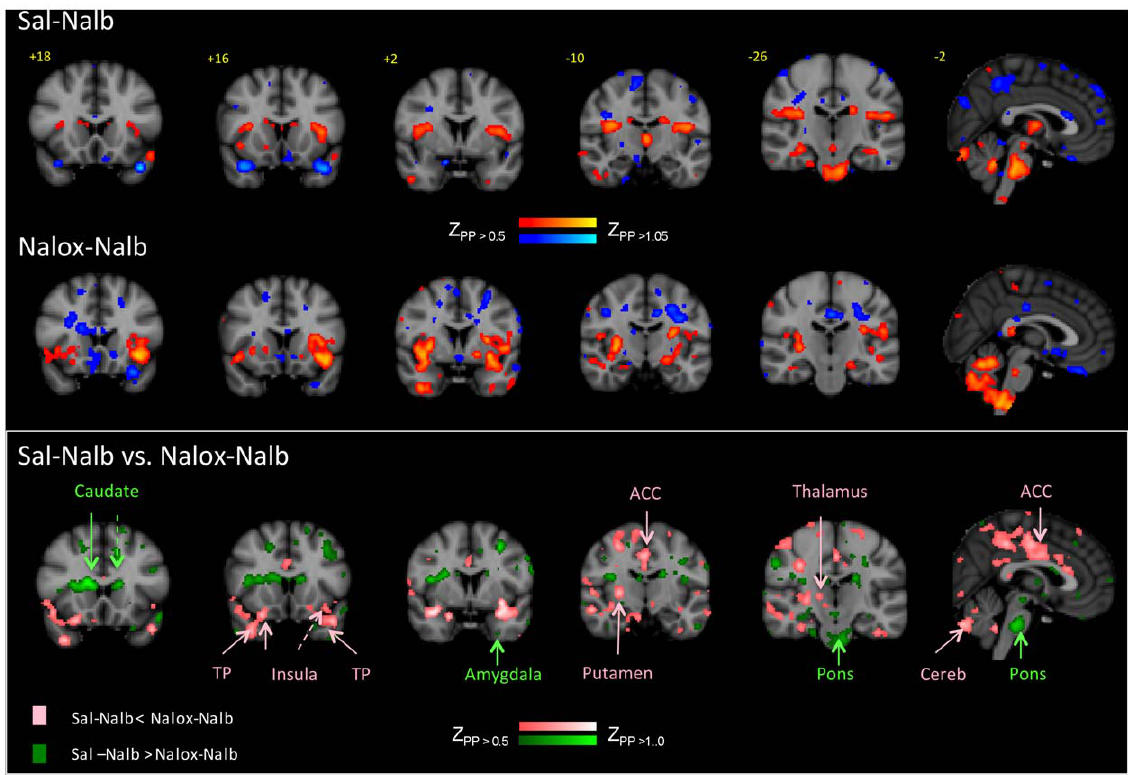
Figure 3. BOLD phMRI activation maps. Top : BOLD activation maps for Nalb-Sal (see Table 1); middle: BOLD activation maps for Nalb-Nalox infusions (see Table 2). Bottom: Contrast maps for Nalb-Sal . Nalb-Nalox and Nalb-Nalox . Nalb-Sal (see Table 3).